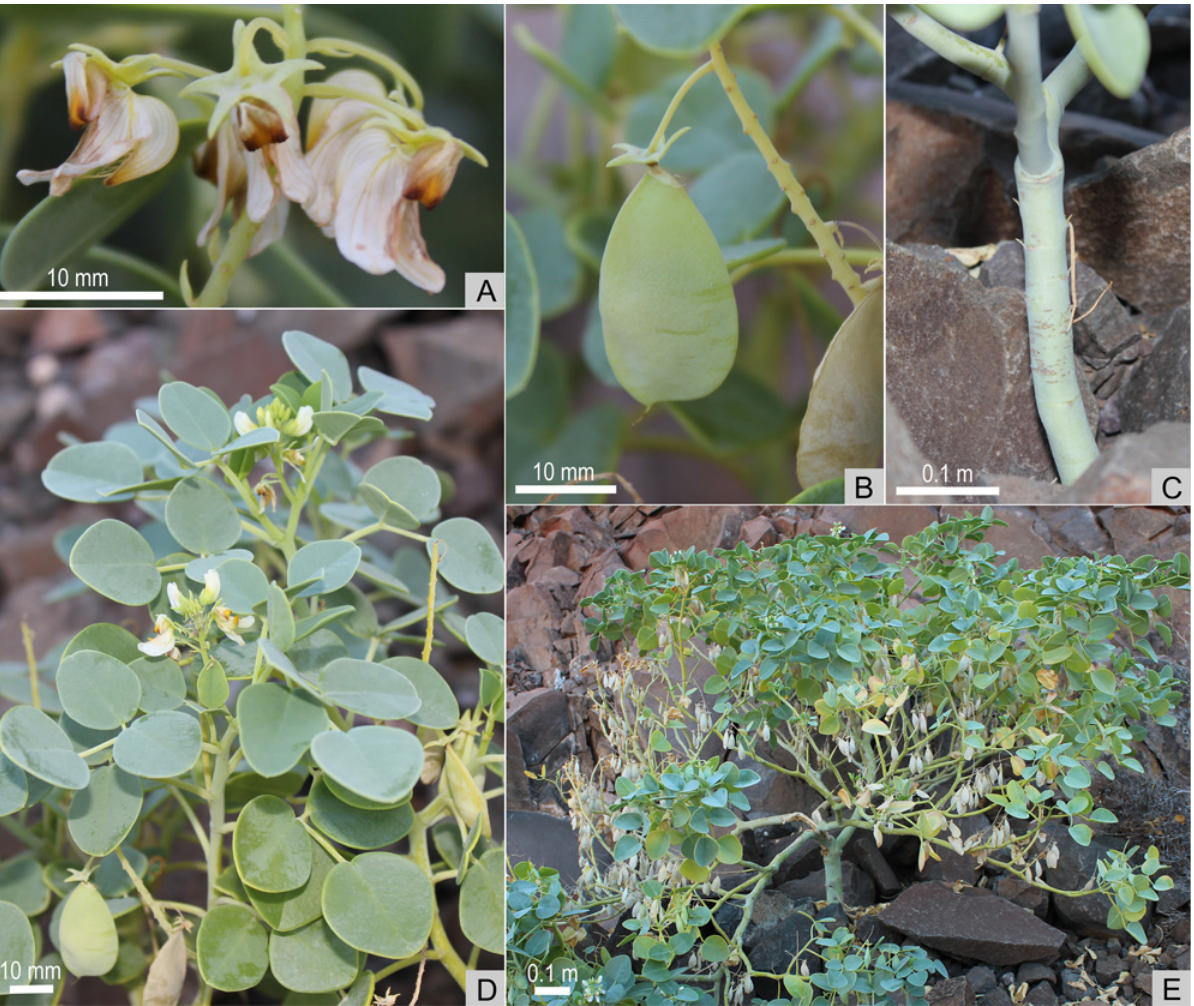
Fig 6. Habit and macromorphology of Oberholzeria etendekaensis . Photographs illustrating the morphology of the plants. (A) Flowers with rostrate keels, reflexed standards, paired dark-brown spots at the bottom of the standard blades and dorsiventrally flattened, equally 5-lobed calyces. (B) Laterally flattened and somewhat inflated fruit. (C) Succulent stem. (D) Leaf-opposed inflorescences and pinnately trifoliolate leaves. (E) Habit; biennial or short-lived perennial succulent shrublet. Photos: W. Swanepoel.